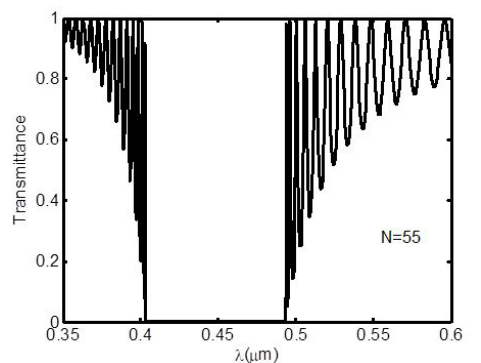
Figure 1. Schematic diagram of Fibonacci quasi-periodic 1DPC consisting of alternate the metamaterial (M) and the superconducting material (S) under any incidence angle. The thicknesses of M and S are denoted by d2 and d3, respectively. And the corresponding refractive indices are separately indicated by n1, n2, and n3, where n1 = 1 is taken.